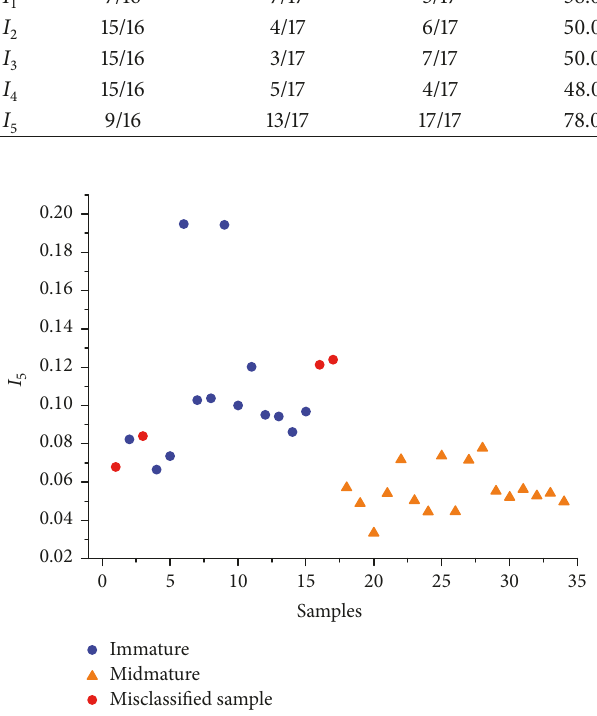
Figure 4: Classification of midmature and mature navel oranges in calibration set by